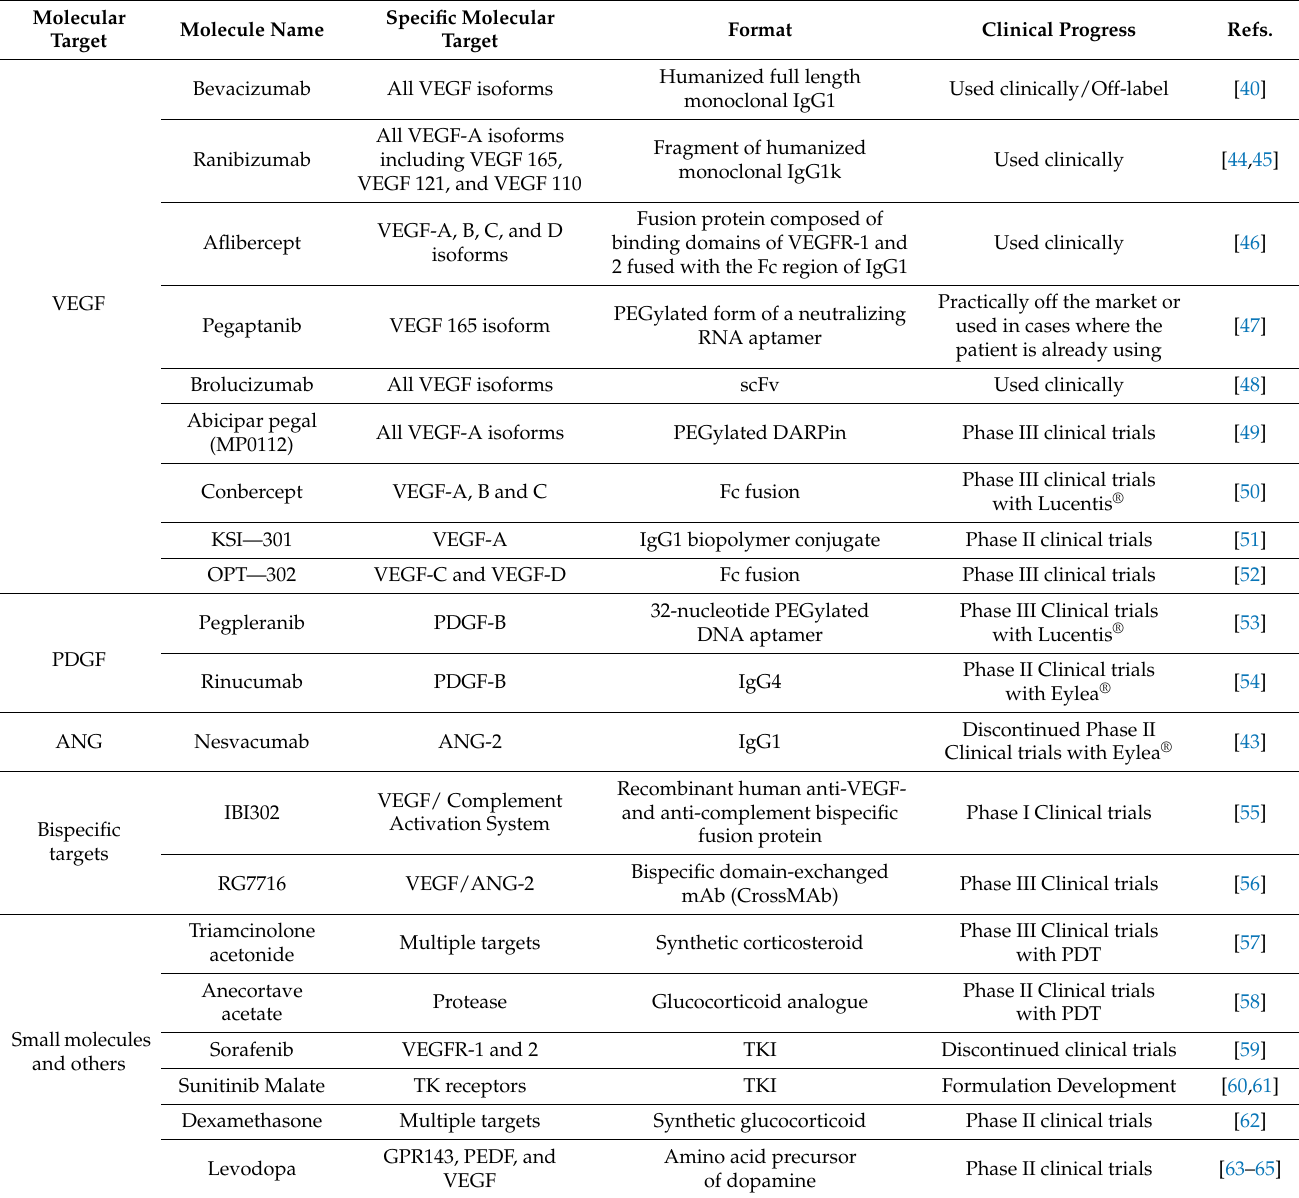
Table 1. Molecular targeted strategies for nAMD